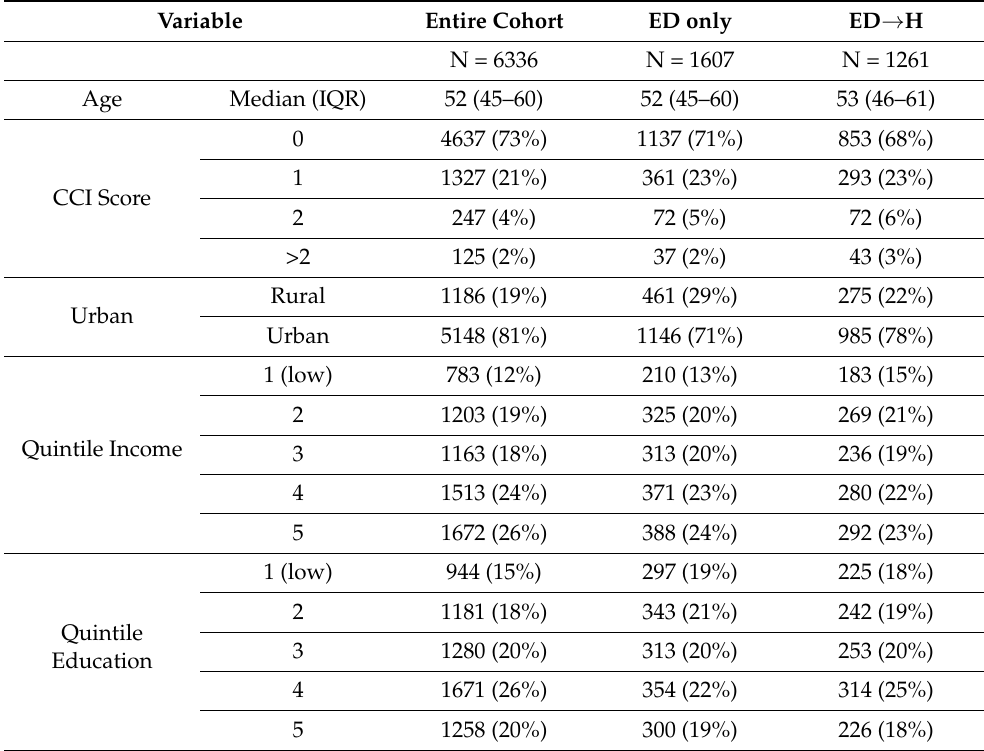
Table 1. Study cohort demographic data. IQR: interquartile